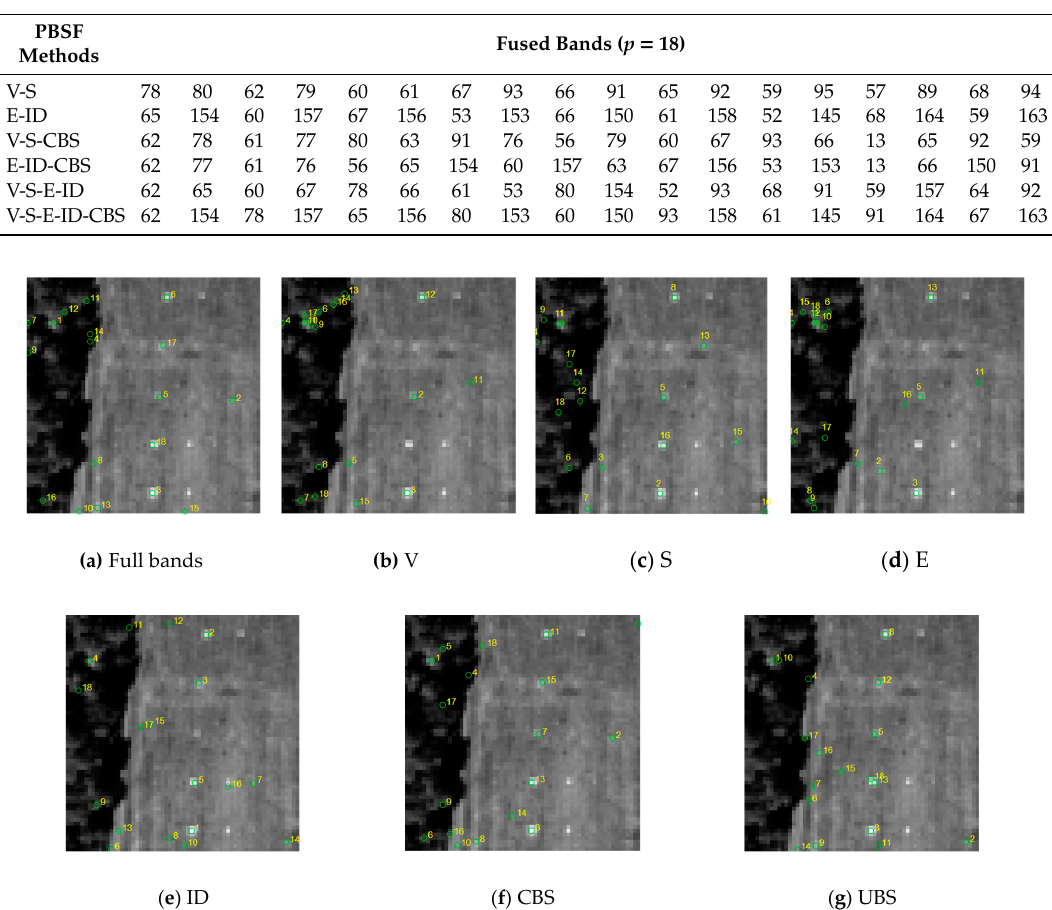
Figure 4. The 18 pixels found by automatic target generation process (ATGP) using the full bands and selected bands in Table 1.